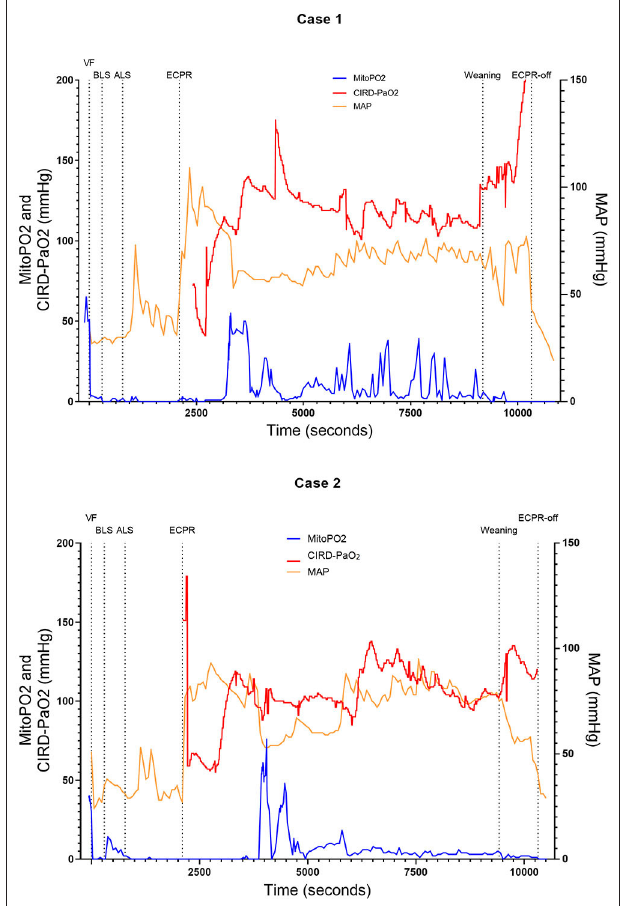
FIGURE 2 | Course of mitoPO 2 , CIRD-PaO 2 , and MAP for experimental tests case 1 and 2. Course of mitoPO 2 and CIRD-PaO 2 in mmHg levels at the left Y -axis and course of MAP in mmHg levels at the right Y -axis all over time in seconds. Case 1 at the above panel and case 2 at the below panel. VF, ventricular fibrillation; ECPR, extracorporeal cardiopulmonary resuscitation; CIRD-PaO 2 , arterial partial oxygen pressure measured by controlled integrated resuscitation device; mitoPO 2 , mitochondrial partial oxygen pressure.